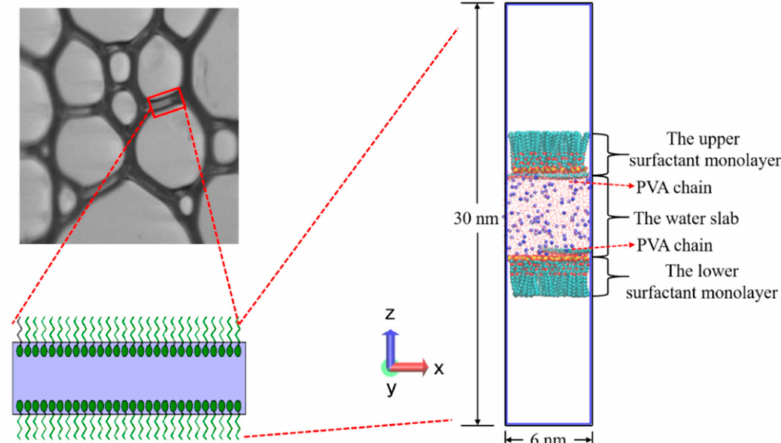
Figure 3. The sandwich model for simulations based on the real liquid film structure in the